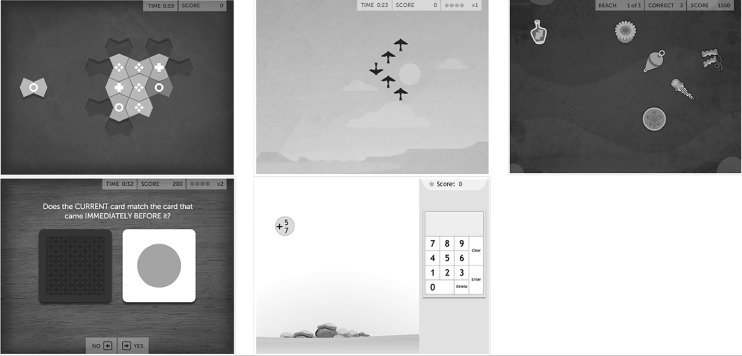
Screenshots of Lumosity Cognitive TrainingTM games (http://www.lumosity.com).Legend. Top to bottom, left to right: Disillusion, Lost in Migration, Tidal Treasures, Speed Match, Raindrops.